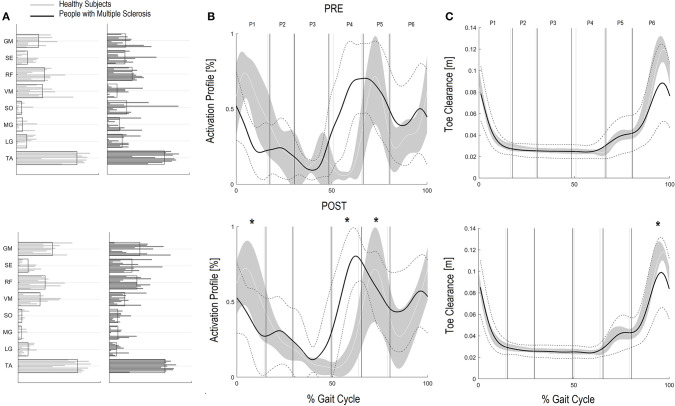
Ground Clearance Muscle Synergies (GCM) and Foot clearance. Weightings (A) and activation profile (B) of GCM and toe marker trajectory curve (C) for persons with multiple sclerosis (PwMS) pre (top panel) and post (bottom panel) treatment and speed-matched healthy subjects (HS). In (B,C) the solid black line represents the averaged profile of PwMS and the dashed black lines represent ± SD of PwMS curves. Vertical lines (solid gray line—healthy subjects and solid black line—PwMS) indicate the six phases of a normalized gait cycle (P1, early stance; P2, mid stance; P3, terminal stance; P4, pre swing; P5, early swing; P6, late swing). *p < 0.05 at paired t-test of Z-score, pre- vs. post-treatment, for activation percentage index of GCM (B) or toe clearance (C) in PwMS. +0.05 < p < 0.1 at paired t-test of Z-score, pre- vs. post-treatment, for activation percentage index of GCM (B) or toe clearance (C) in PwMS.